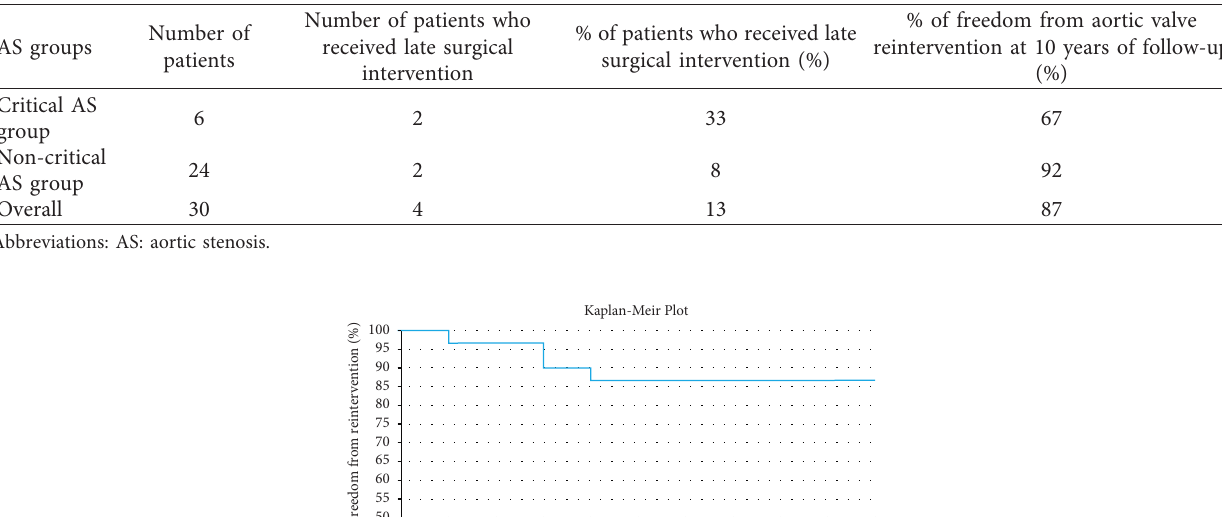
Table 4: Percentage of patients who received late surgical intervention and % of freedom from aortic valve reintervention at 10 years of follow-up in the groups of critical and noncritical AS, respectively.